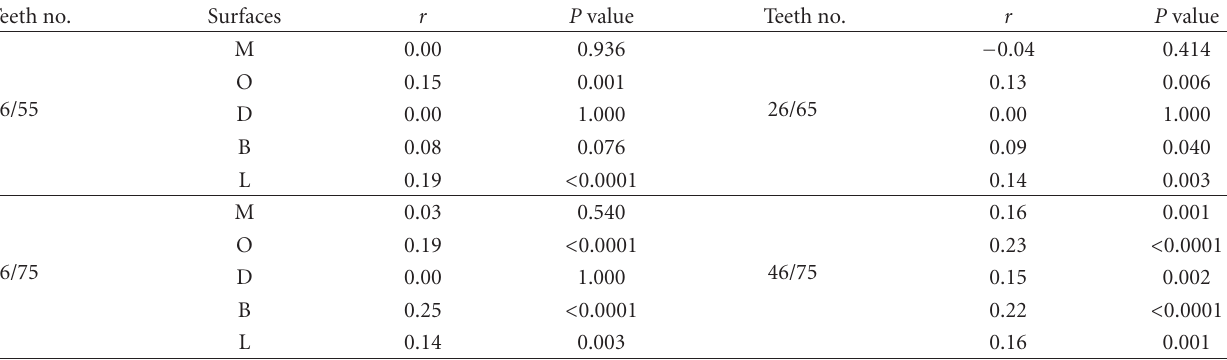
Table 3: The Spearman correlation coe ffi cients ( r ) between the first permanent molars and the second primary molars according to the surfaces.